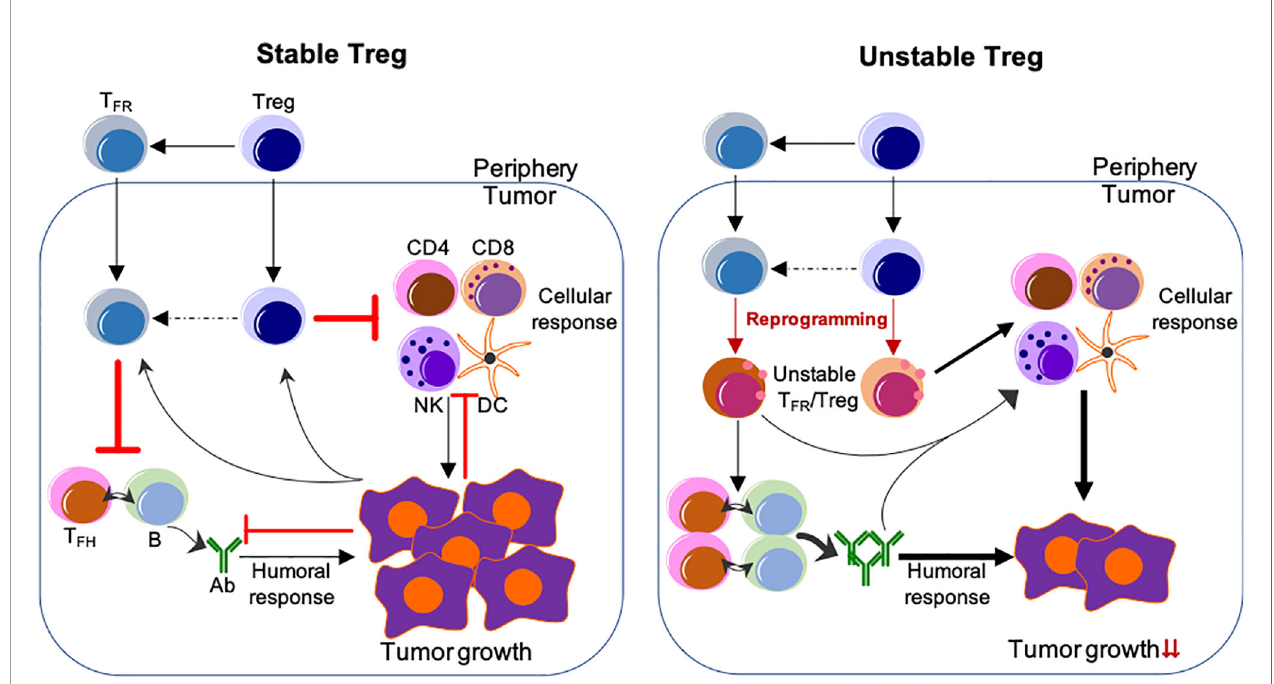
FIGURE 1 | Reprogramming of TIL Tregs to control tumor by targeting their stability. Left , Stable Treg. Treg and T FR cells mainly suppress the cellular and humoral anti-tumor immune responses, respectively. Conversely, tumor cells impose suppression on both cellular and humoral immune responses, but foster the immune suppression by Treg and T FR cells. Right , Unstable Treg. Factors or approaches destabilize or reprogram Treg and T FR cells into effector-like cells, which display impaired suppressive activity, but instead cooperate with both cellular and humoral anti-tumor components to control tumor growth and progression. The peripheral events are not depicted, but strategies used to selectively reprogram TIL Tregs, but not Tregs in the periphery, are expected to be most effective without systemic adverse effects. The unclear events are indicated by dashed lines. Not depicted: Peripheral T FH and B-cells and their migration into the tumor; expansion of Treg/T FR cells and anti-tumor effector cells; other cells regulating anti-tumor responses (e.g., myeloid-derived suppressor cells and macrophages,